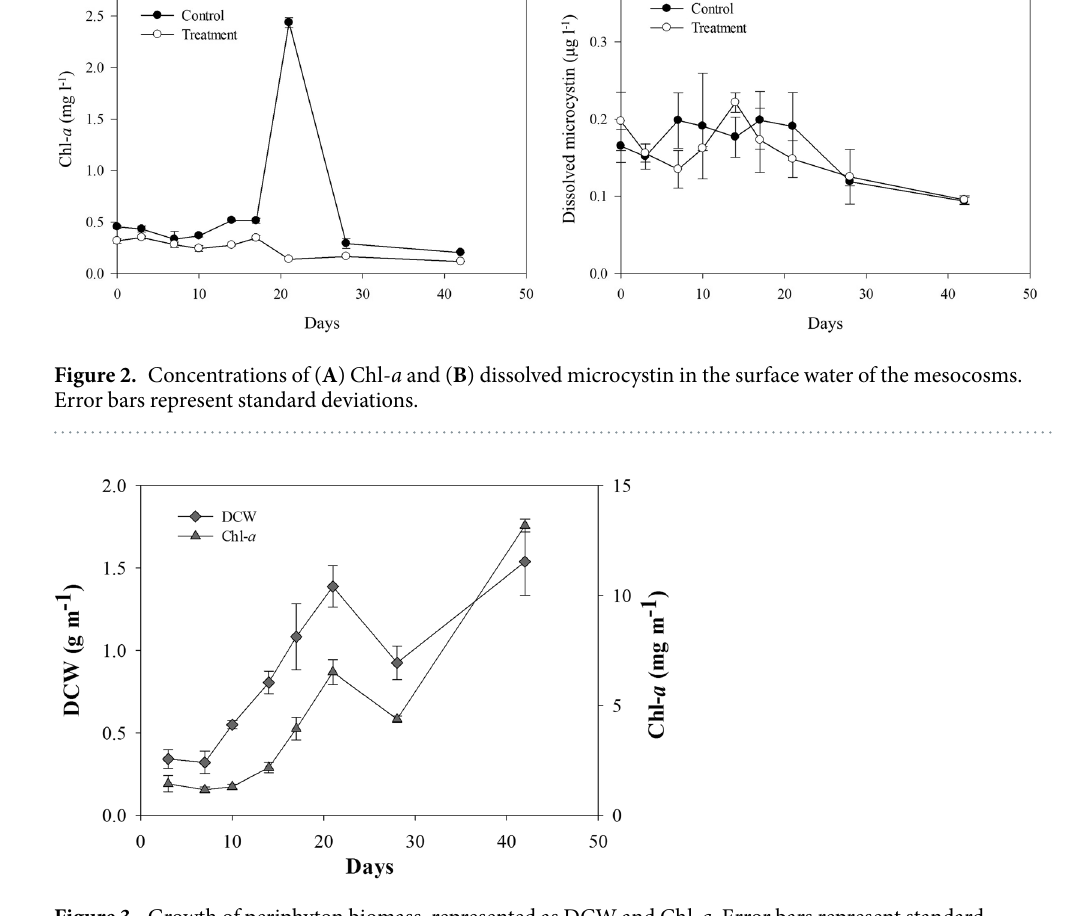
Figure 3. Growth of periphyton biomass, represented as DCW and Chl- a . Error bars represent standard